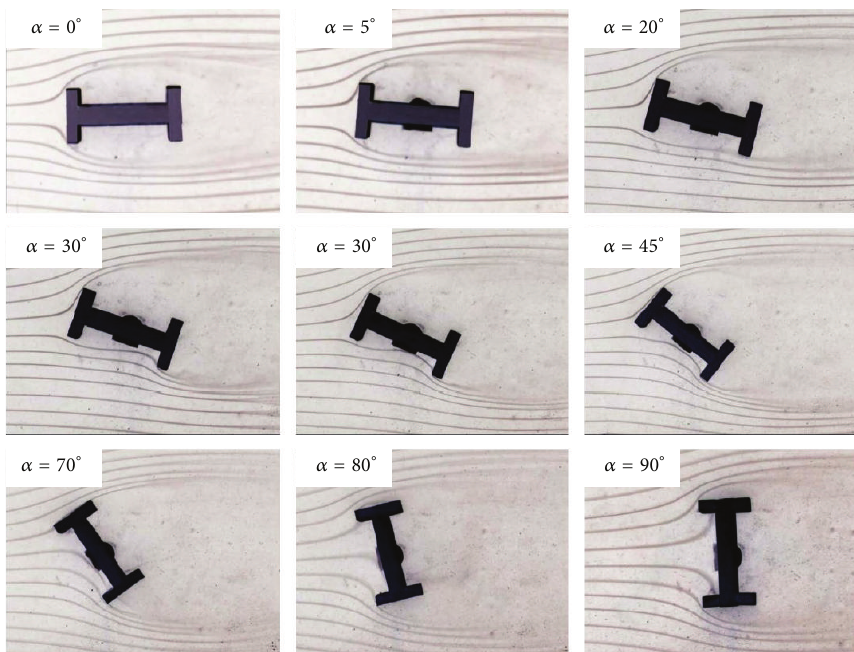
Figure 5: Smoke visualization of the flow past an H beam with geometrical parameters 2𝑎/𝑐 = 0.25 and 𝑏/𝑐 = 0.45 ; note that the colours are inverted to enhance visualization according to Gand´ıa et al. [16].